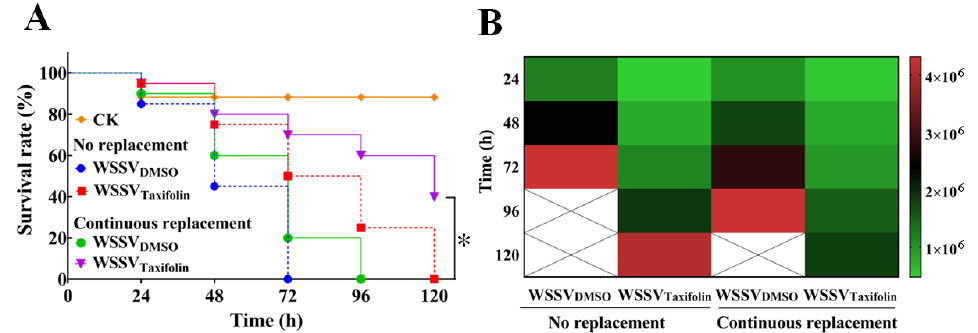
Figure 5. Continuous treatment of taxifolin further inhibited WSSV replication in vivo. Aquacultural water and new taxifolin were exchanged or non-exchanged every 24 h, respectively. ( A ) Survivorship curves of WSSV-infected shrimp were analyzed. ( B ) Quantification of copy number of the WSSV genome was tested every 24 h. The p value was determined by Student’s t -tests. * p < 0.05.